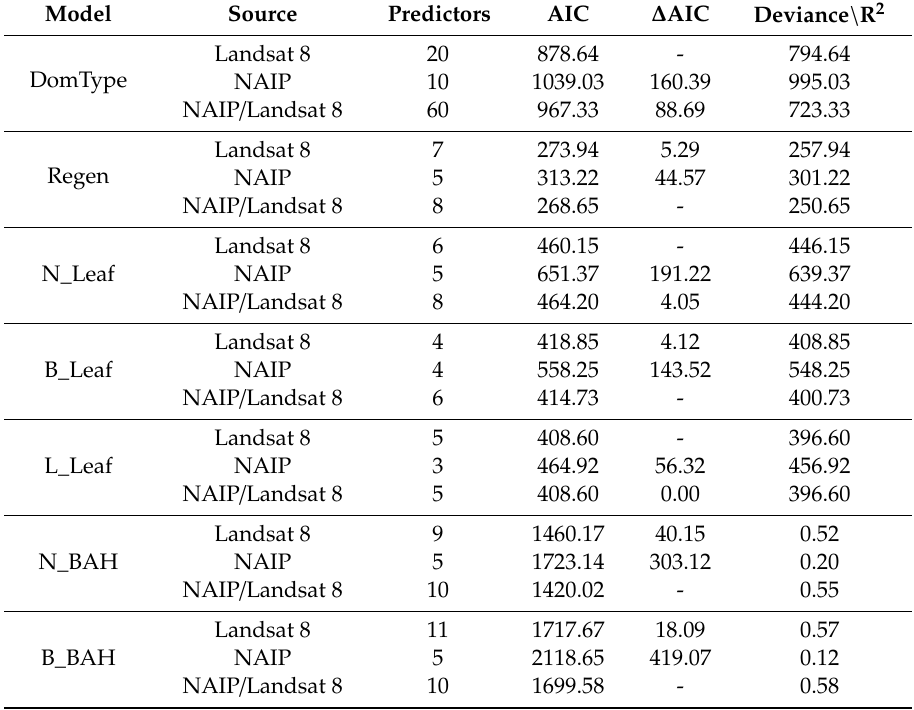
Table A3. Model, data source for predictors, number of predictors, AIC, delta AIC and deviance and coefficient of determination (R 2 ) of candidate NAIP only, Landsat 8 only and combined NAIP/ Landsat 8 based models.